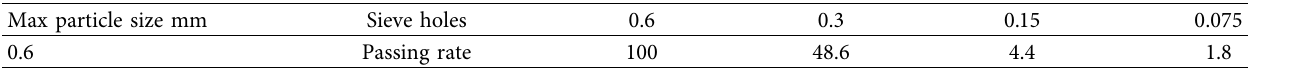
Table 4: Fine sand sieving results.